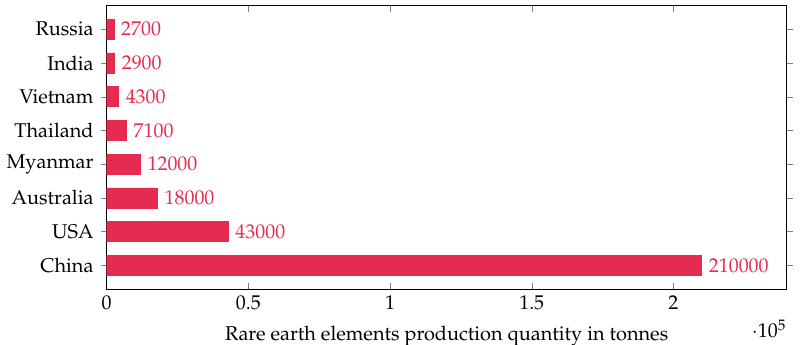
Figure 19. Countries with most rare earth metals production in 2022 [135].